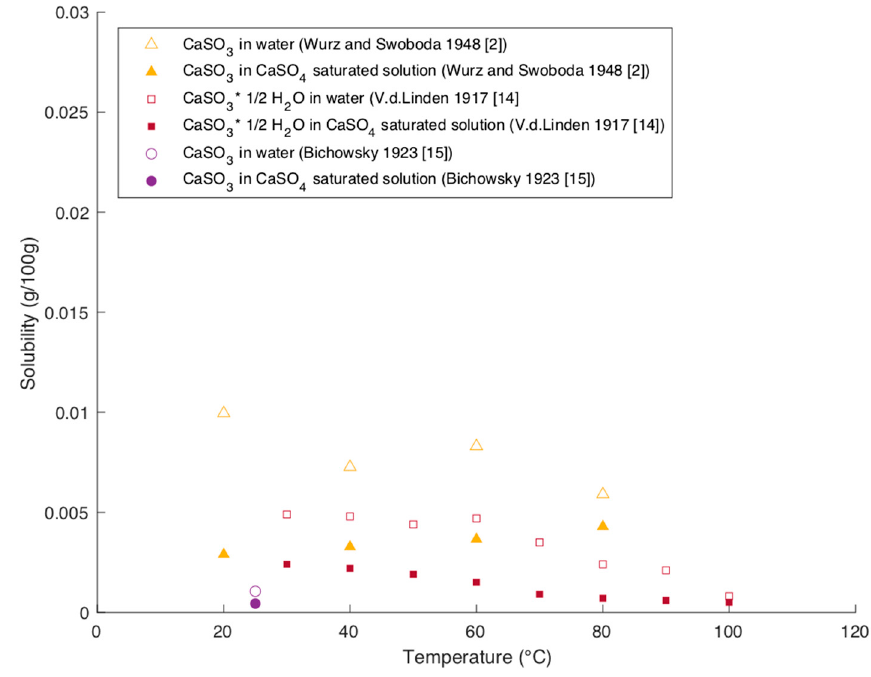
Figure 8. Solubility of CaSO 3 in water and in CaSO 4 saturated solution [2,14,15].